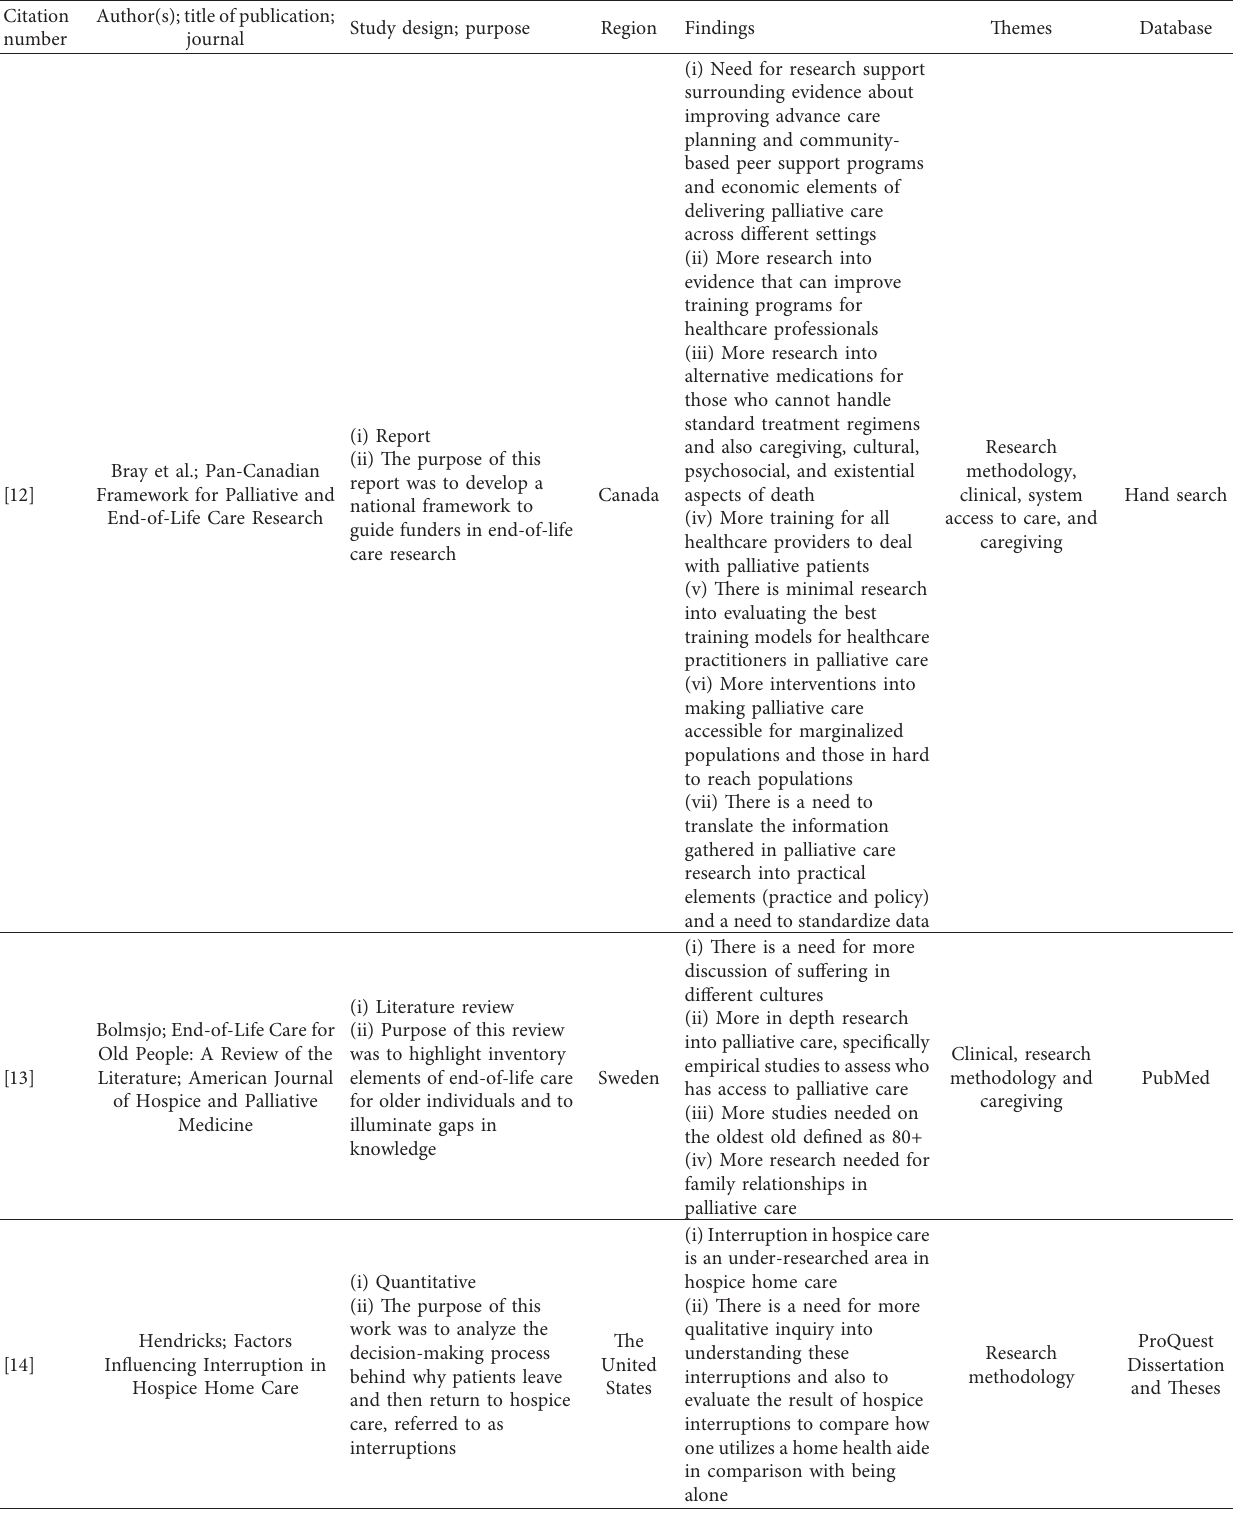
Table 1: Data extraction